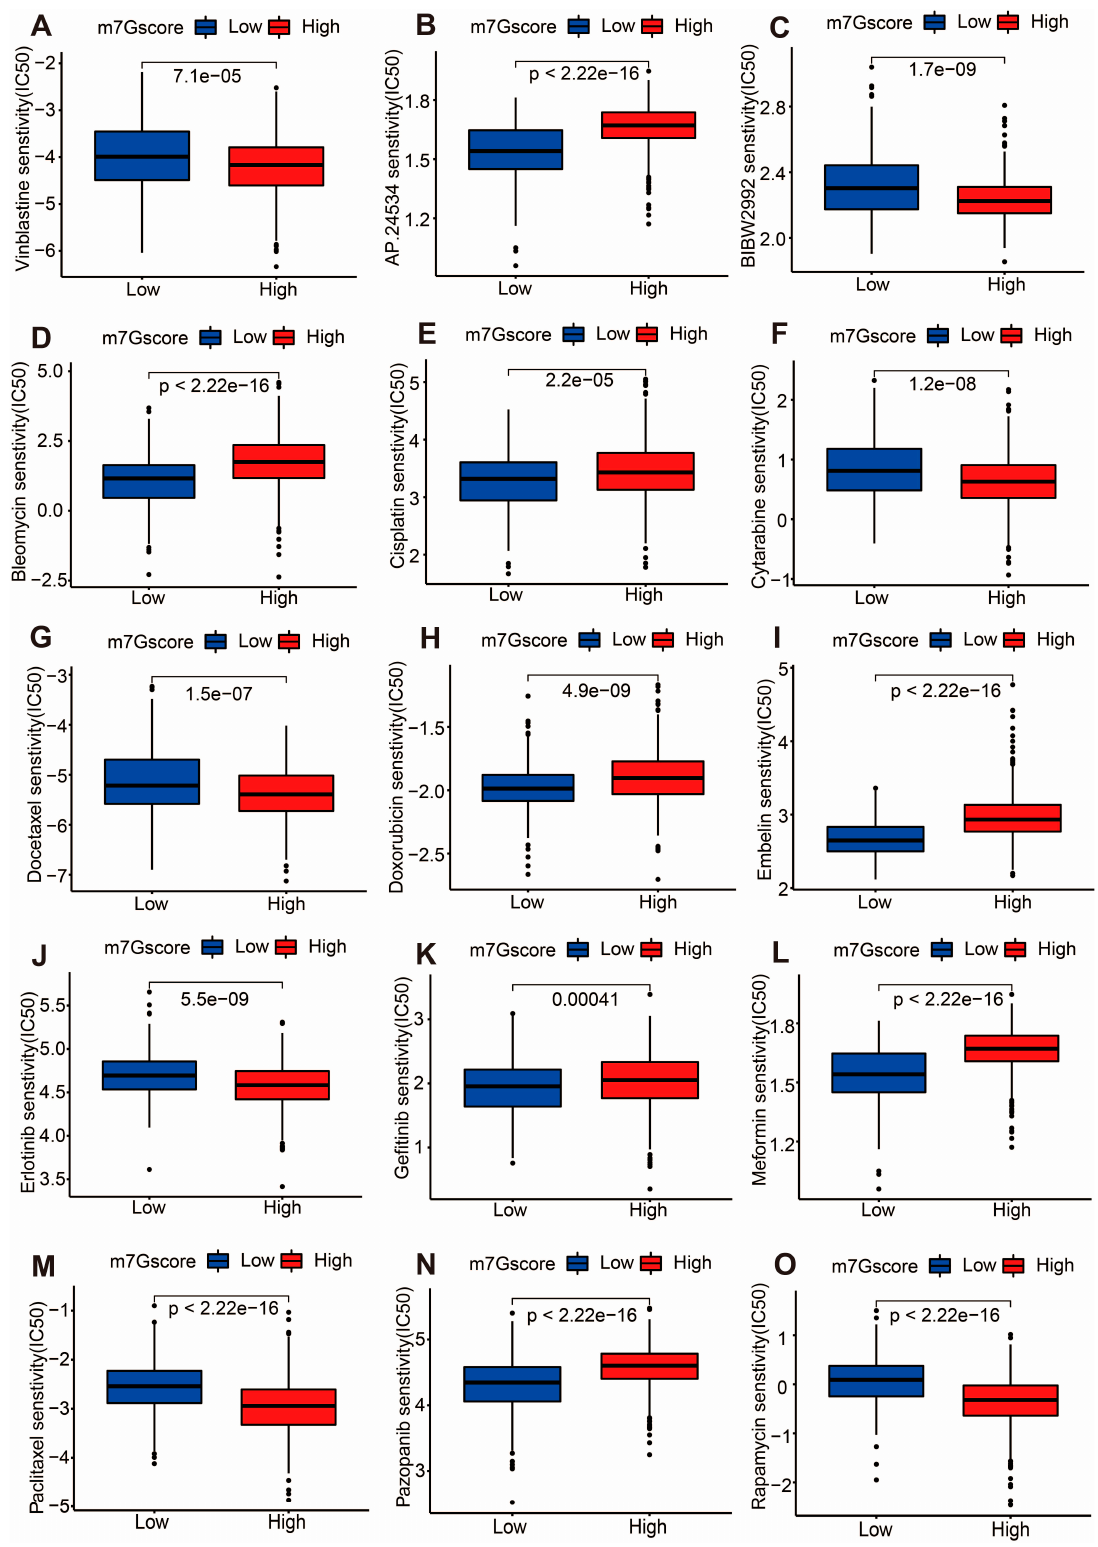
Figure 8. Drug sensitivity in CC patients from different m7G score groups. ( A – O ) Boxplots depicting the IC50 value of Vinblastine ( A ), AP.24534 ( B ), BIBW2992 ( C ), Bleomycin ( D ), Cisplatin ( E ), Cy- tarabine ( F ), Docetaxel ( G ), Doxorubicin ( H ), Embelin ( I ), Erlotinib ( J ), Gefitinib ( K ), Meformin ( L ), Paclitaxel ( M ), Pazopanib ( N ), and Rapamycin ( O ) in CC patients with different m7G